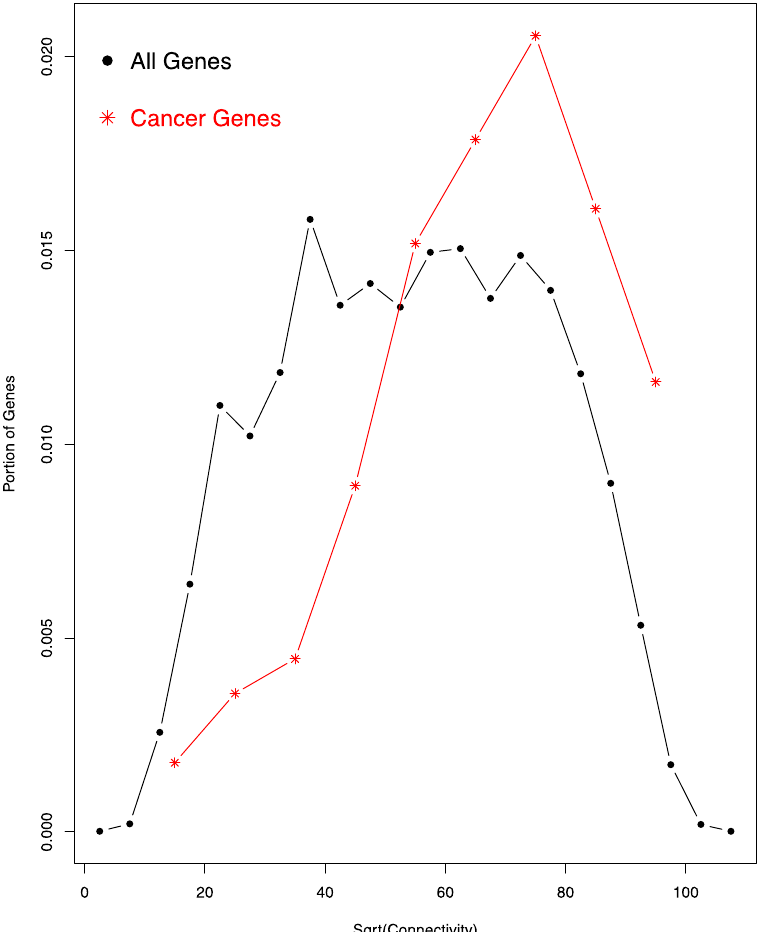
Figure 3. Cancer genes have higher connectivity in the network. A comparison of the histograms of the square root (sqrt) of all genes (black dots and lines) and cancer genes (red stars and lines) is shown. The histogram of cancer genes exhibits a significant right shift. According to bootstrapping, the difference in the connectivity of the two groups has a p -value smaller than 0.001 (see text for detail).